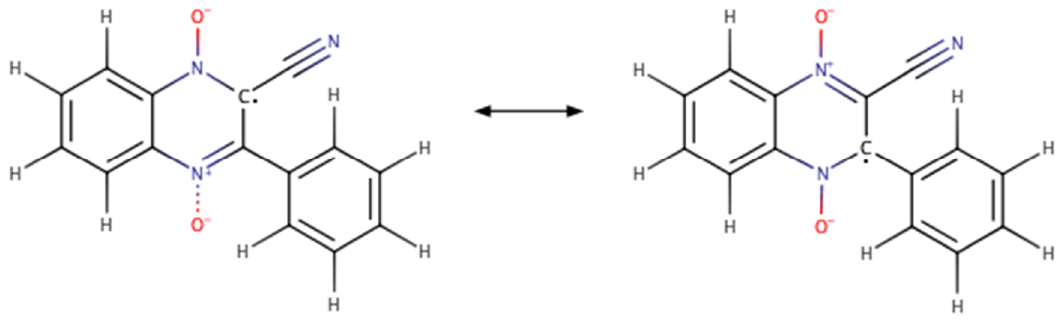
Table 3. The electrochemical cell reaction potentials (εcell) in volts with the standard hydrogen electrode (SHE) reduction potential set to zero for Wave 1, Nitro Wave, and Wave 2 calculated using DFT: BYL3P with lanl2dz and 6-31g basis sets in Gaussian 09.